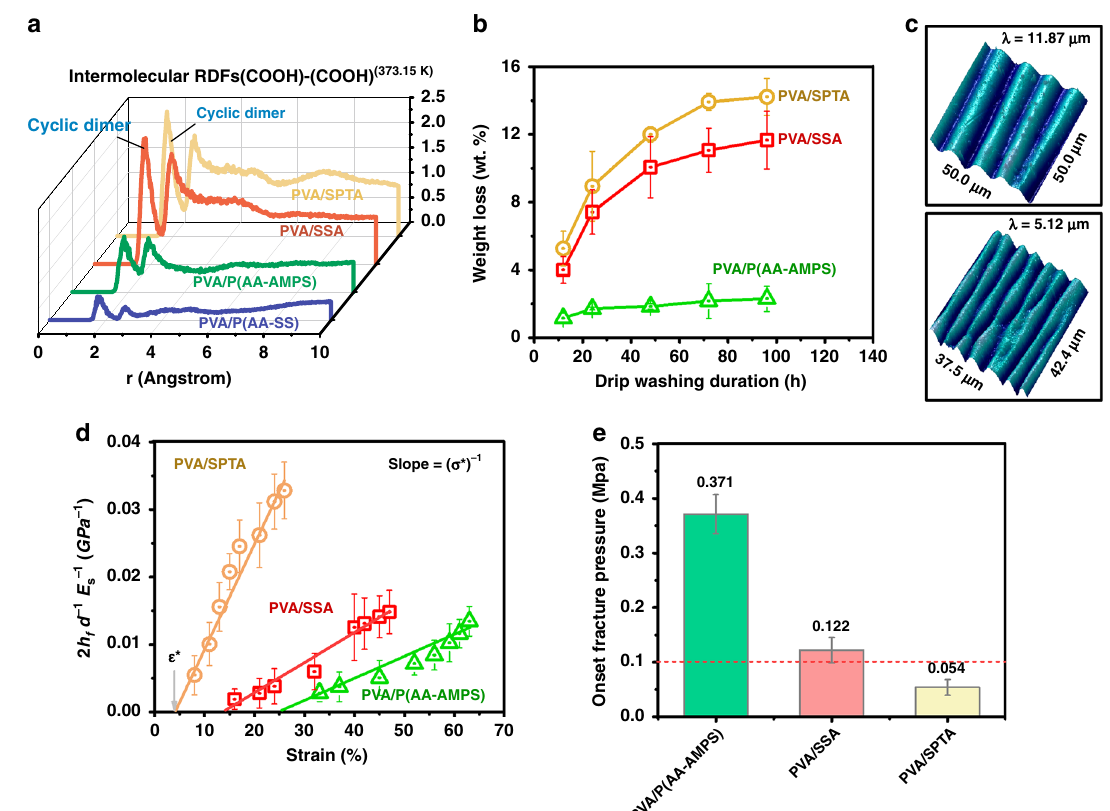
Fig. 2 Characterization of the crosslinked PVA fi lms. a The radial distribution functions (RDFs) of the COOH/COOH groups in the PVA/crosslinkers blending cells at 373.15 K. b The weight losses of the free-standing crosslinked PVA thick fi lms during the drip-washing test at 80 °C for 4 days. c The wrinkle patterns of the crosslinked PVA thin fi lms observed using AFM. d The crack density (2 h the water-swollen crosslinked PVA thin fi lms. e The onset fracture pressures of the PVA/PAN nano fi ber composite membranes. (lines with double caps are error bars, mean ± s.d. for n =